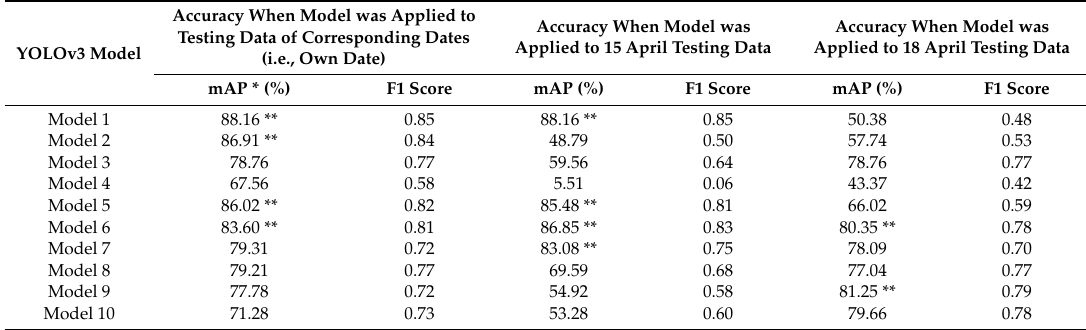
Table 3. YOLOv3 cotton detection models generated from di ff erent training and testing